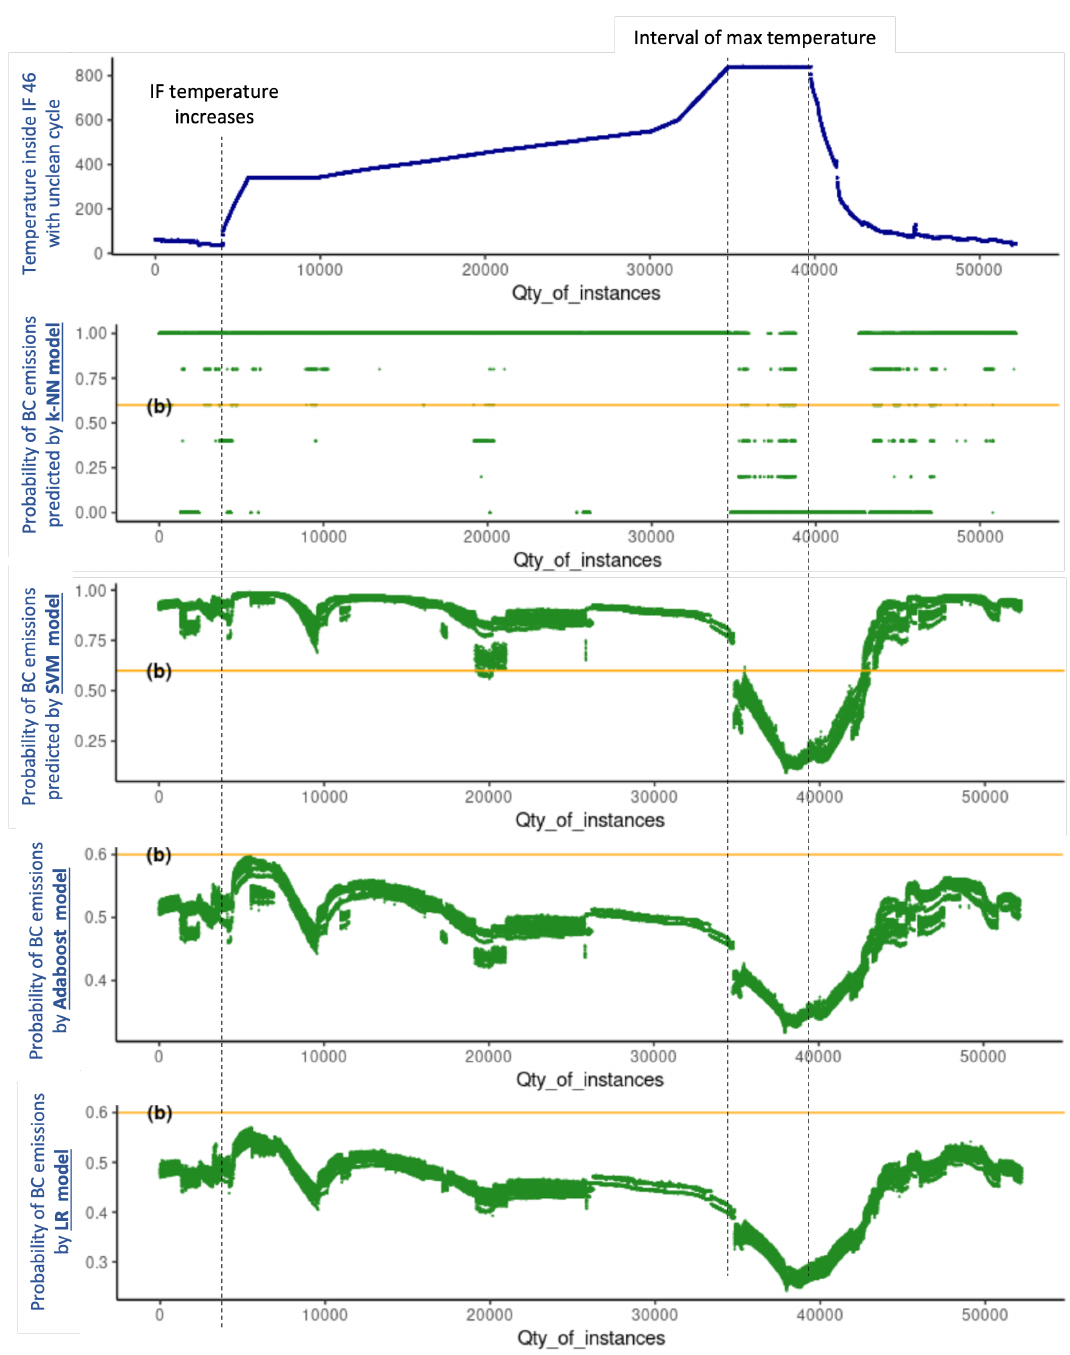
Figure 4. Probabilities of EoBC with clean cycle of all models: k-NN, SVM, Adaboost and